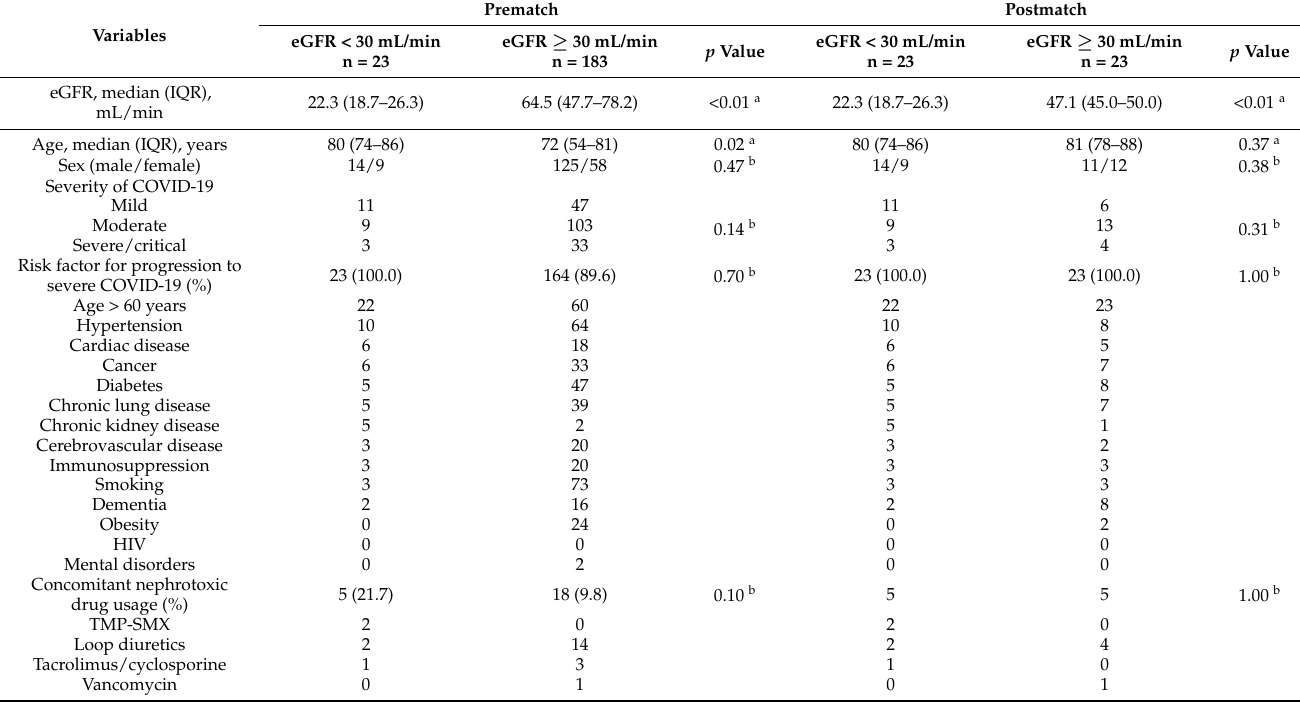
Table 1. Patient characteristics pre- and